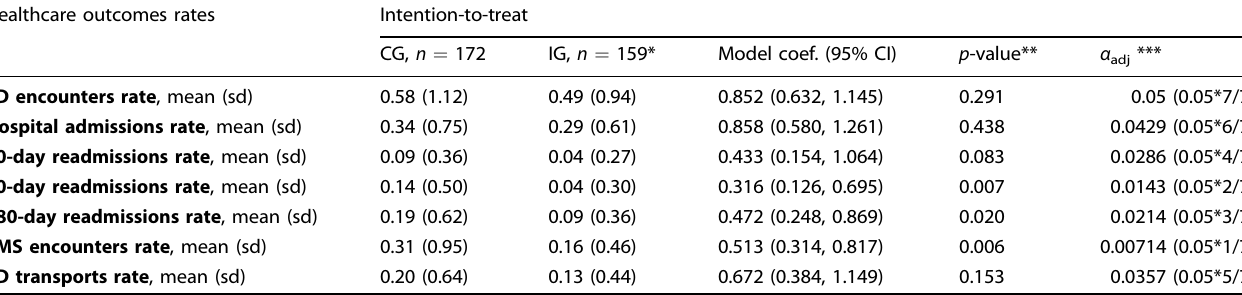
Table 5. Inferential analysis of healthcare outcomes rates. Healthcare outcomes